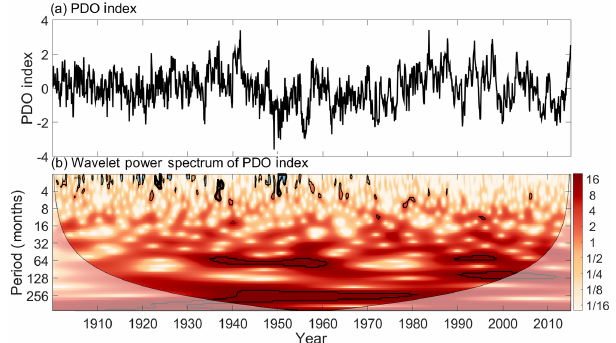
Figure 2. Same as Fig. 1 but for the PDO index.